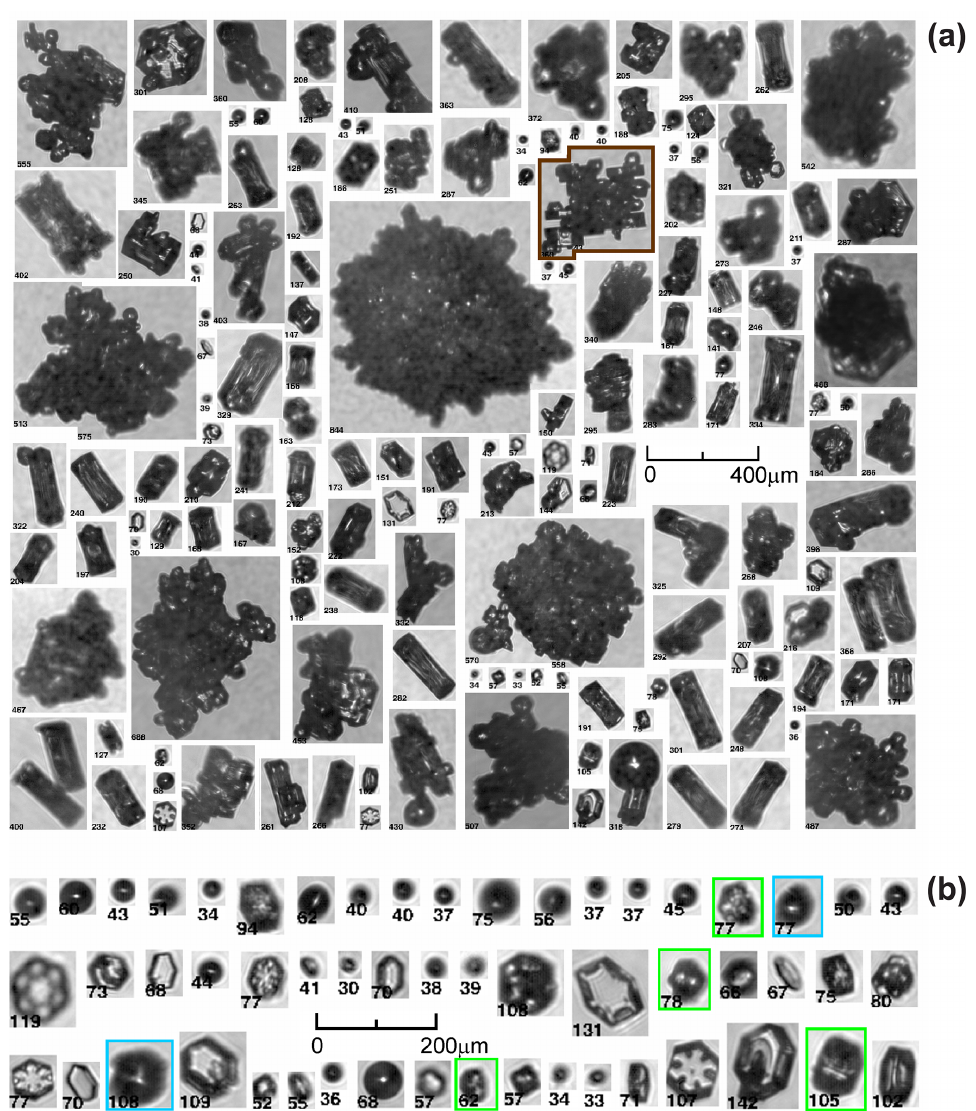
Figure 9. (a) Spatial sequence of CPI images; (b) subset of droplets and faceted ice crystals from panel (a) . (b) Blue frames indicate frozen droplets with modified shapes, and green frames indicate frozen drops with developed facets. Numbers under each image indicate their maximum sizes ( L max ). The images were sampled at T a = − 14 ◦ C and H = 7200m during 12:05:27–12:05:38UTC on 15 May 2015 during measurements shown in Fig. 8.